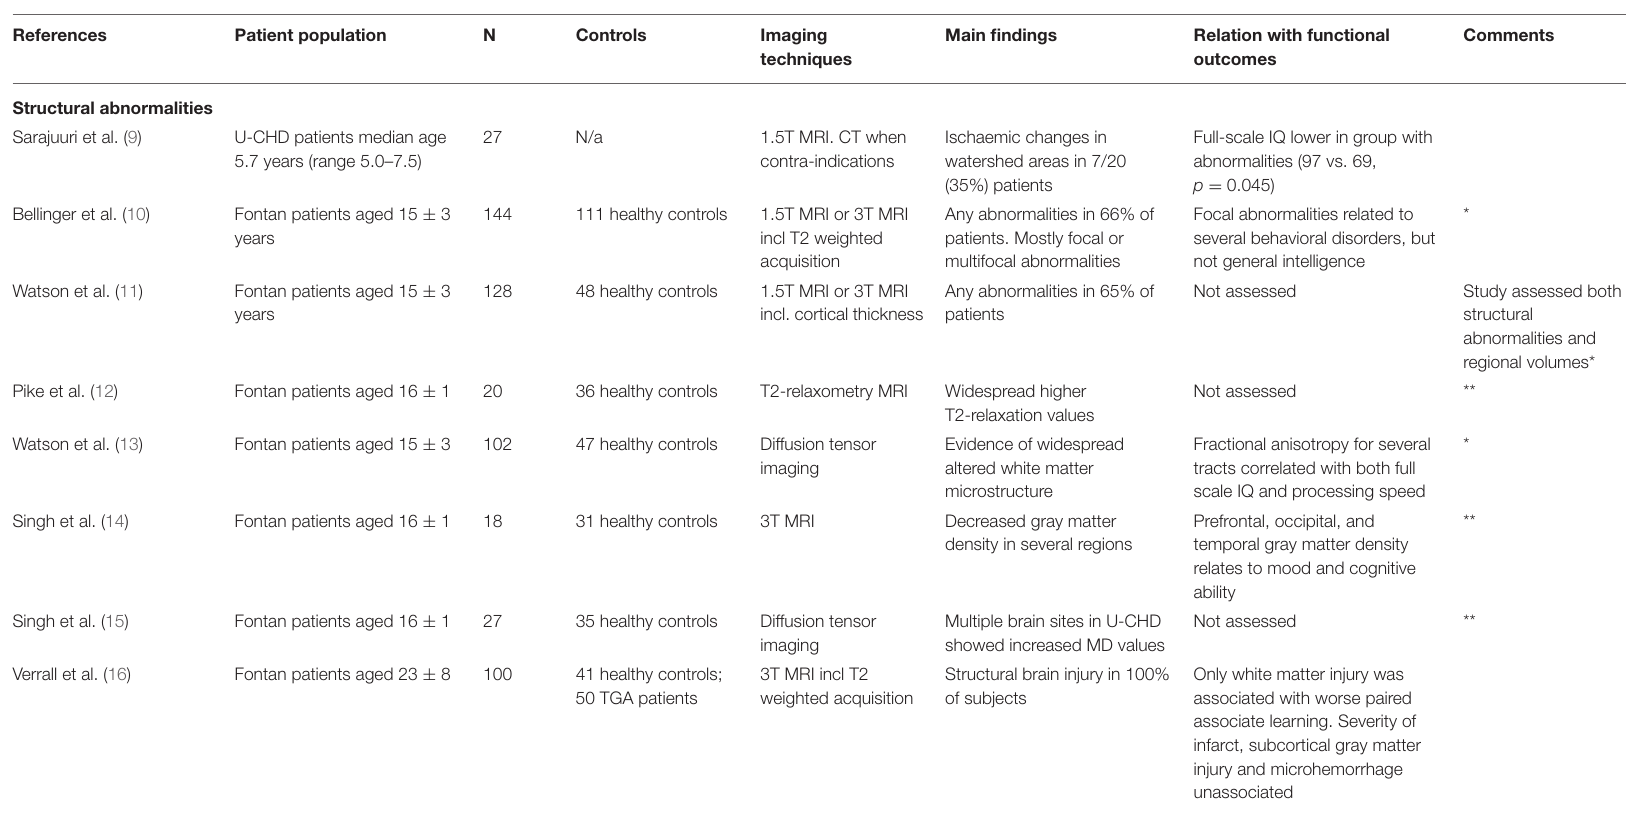
TABLE 1 | Neurologic imaging